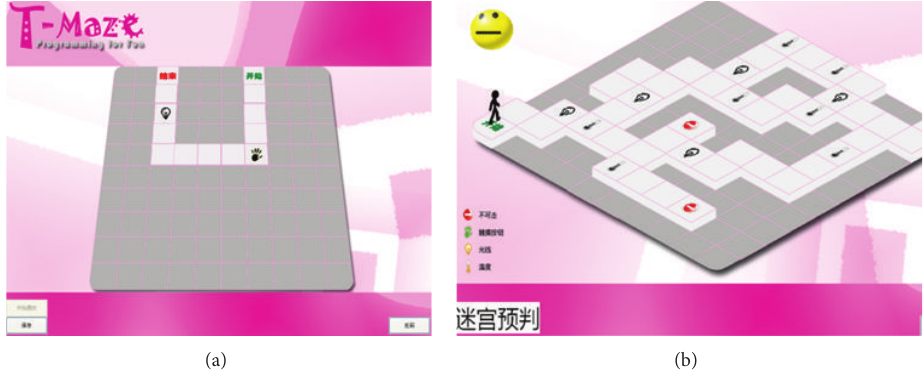
Figure 6: The simple (a) and complex (b) maze-escape games in the